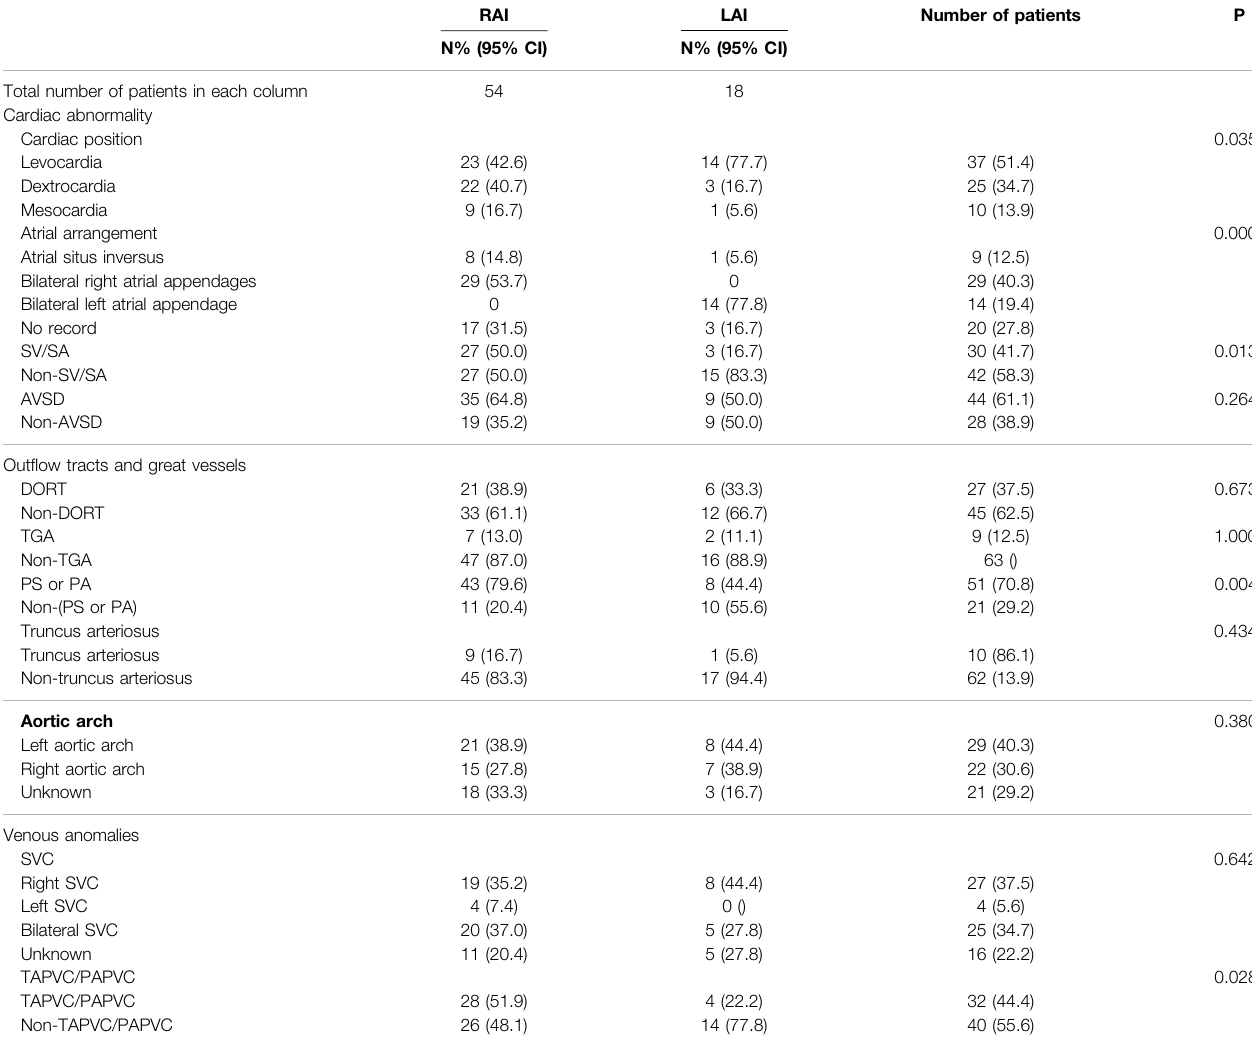
TABLE 1 | Spectrum of cardiovascular abnormalities in right and left atrial isomerism patients. RAI